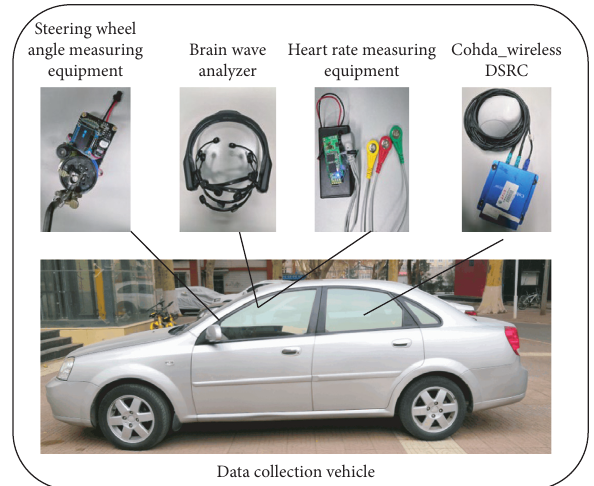
Figure 1: Equipment used for data collection.